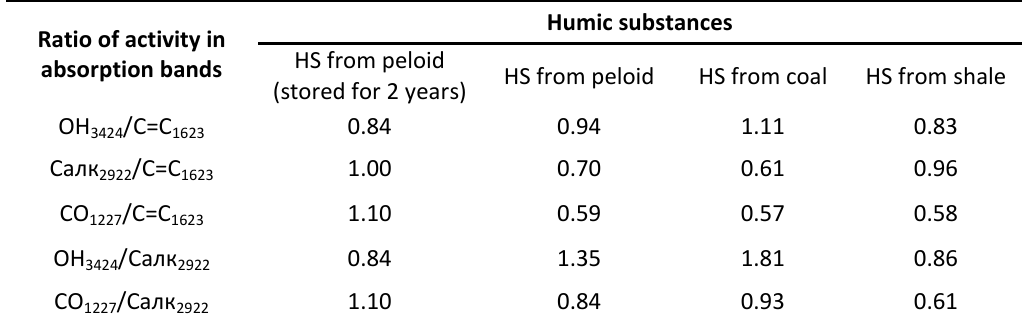
Table 3. Ratio of activity in absorption